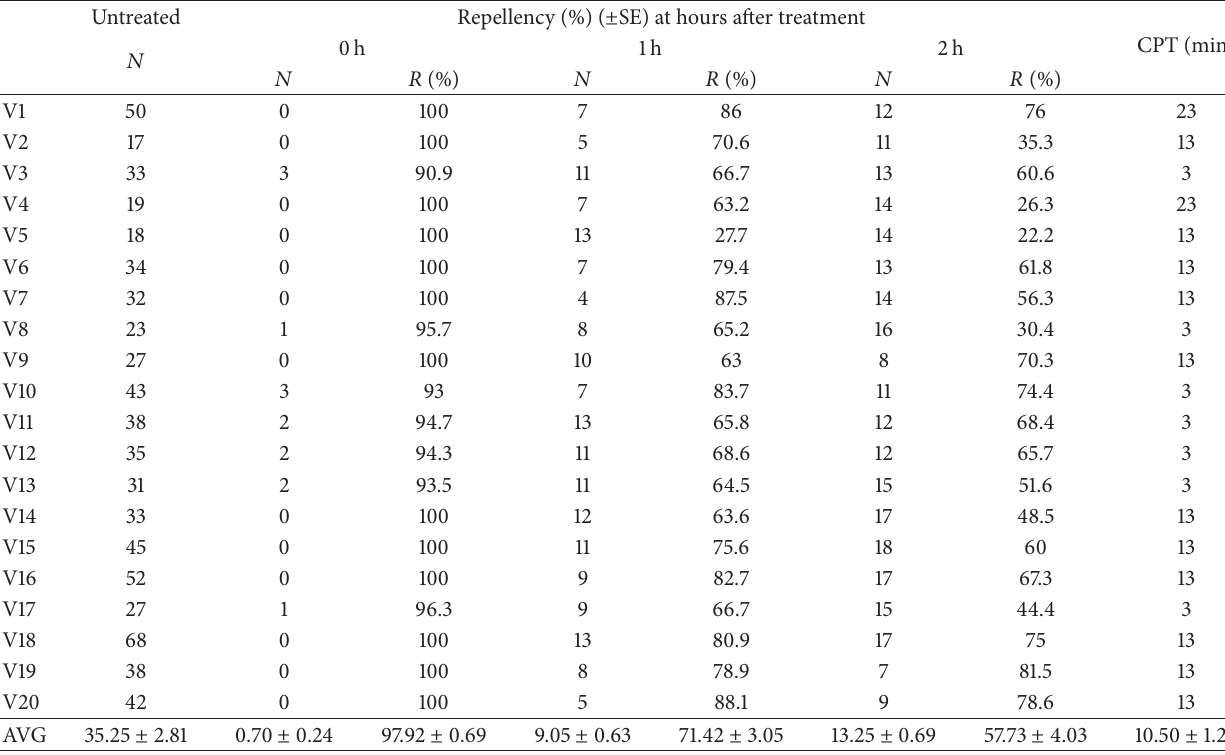
Table 2: Repellency and CPT of 5% citronella oil against Aedes albopictus in laboratory test. Untreated